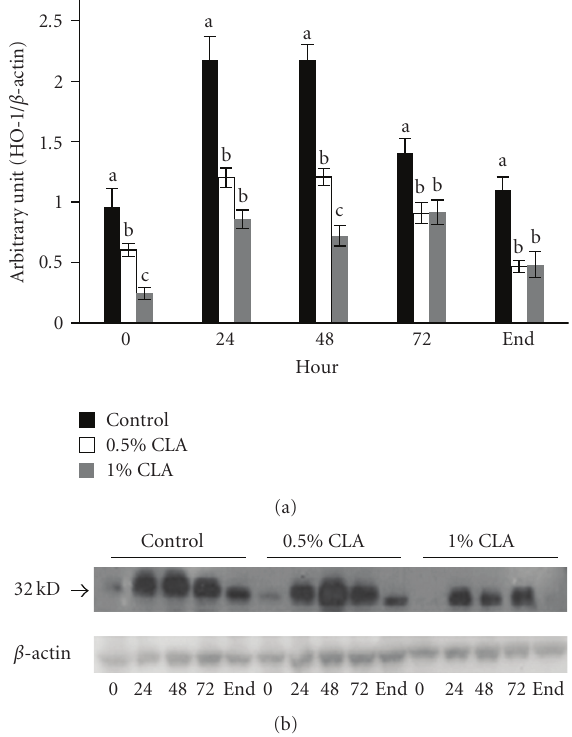
Figure 6: HO-1 protein expression in cutaneous wounds of mice fed diets containing 0 (control), 0.5%, or 1% CLA for 2 weeks. (a) Quantified HO-1 protein expression level determined by densitometry. Values are mean ± SEM; N = 4 to 6 in each group. Means at a time with a di ff erent letter are significantly di ff erent, P < . 05. (b) 0; 0hr, 24; 24 hr, 48; 48 hr, 72; 72 hr after wounding, end (wound is completely